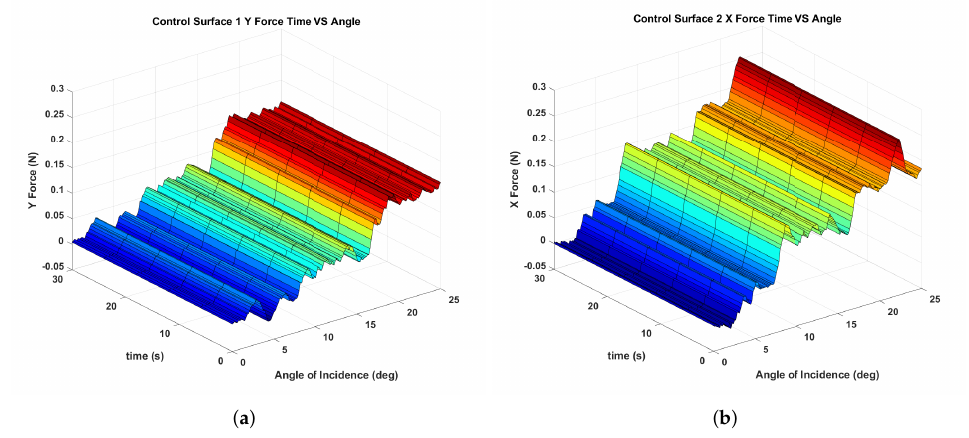
Figure 25. Surface representation for both control surfaces. ( a ) Aileron 1, Y real force angle/time surface. ( b ) Aileron 2, X real force angle/time surface.